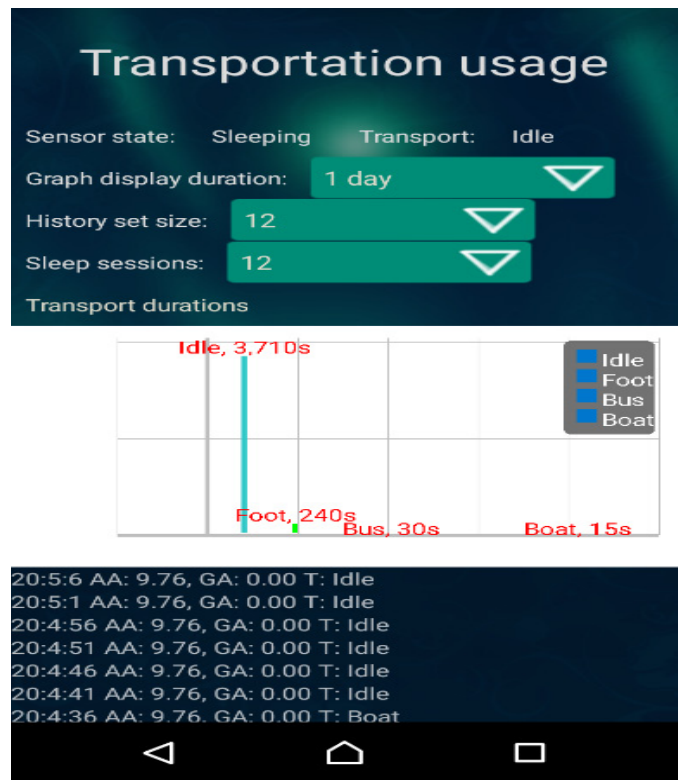
Figure 12. Screenshot of the transportation usage screen. Within Evergreen (1 day).